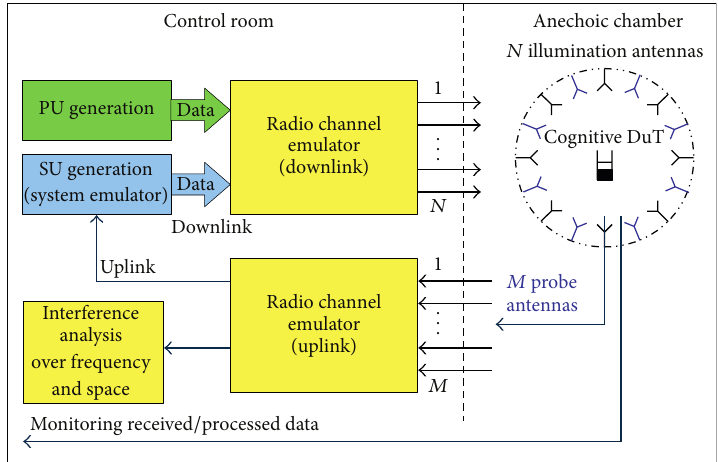
Figure 9: OTA in VEE test-bed realization for closed-loop evaluation of CR